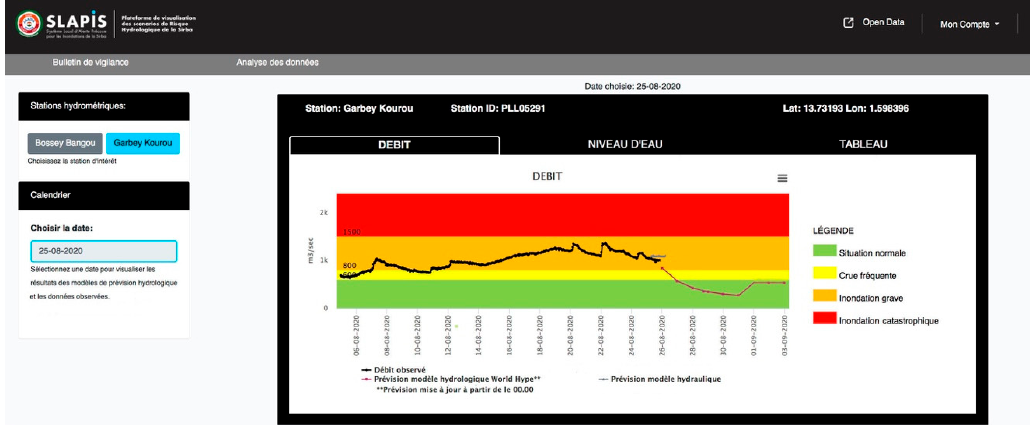
Figure 9. User interface of SLAPIS platform with hydrograph of observed and forecasted discharge in Garbey Kourou the 25 August 2020. The black line is the observed flow, the grey line is the hydraulic forecast, and the red line the WWH optimized forecast.